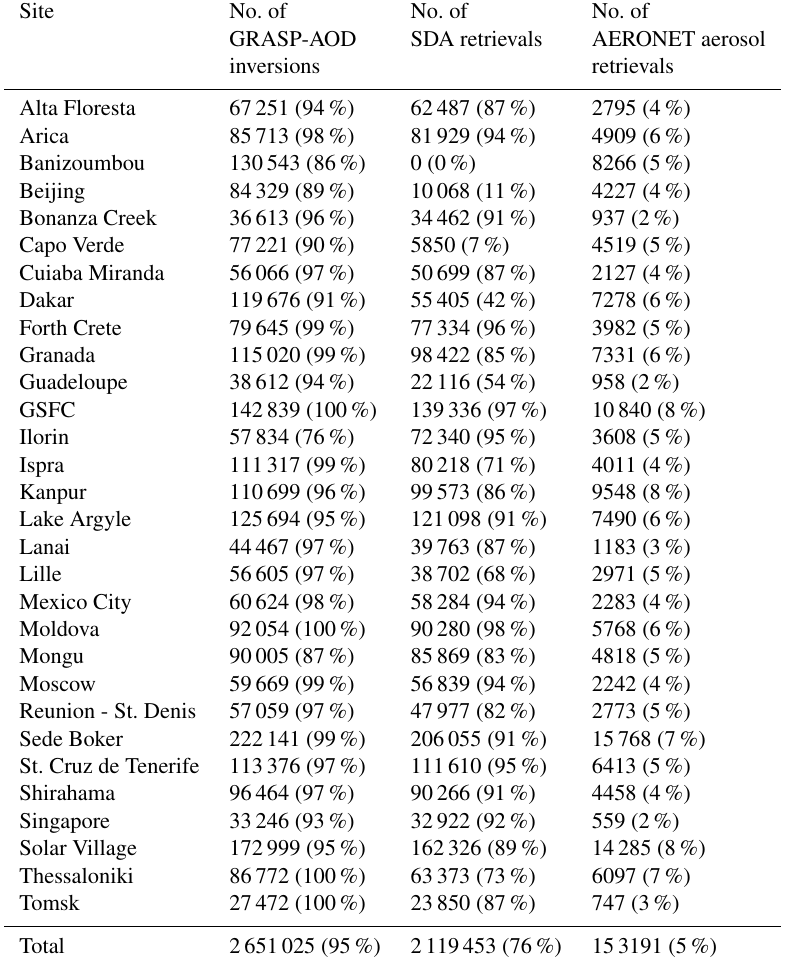
Table 3. Total number of GRASP-AOD inversions, SDA retrievals and AERONET aerosol retrievals for each site. The percentage with respect to the total number of τ measurements is indicated in